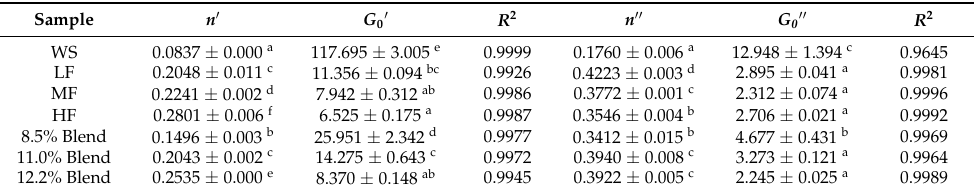
Table 2. Values of n ′, n ″, G 0 ′ , and G 0 ″ for the film -forming matrices of pure WS, wheat flours, and WS – gluten blends with different gluten content (8.5%, 11.0%, and 12.2%) at 25 °C. Sample